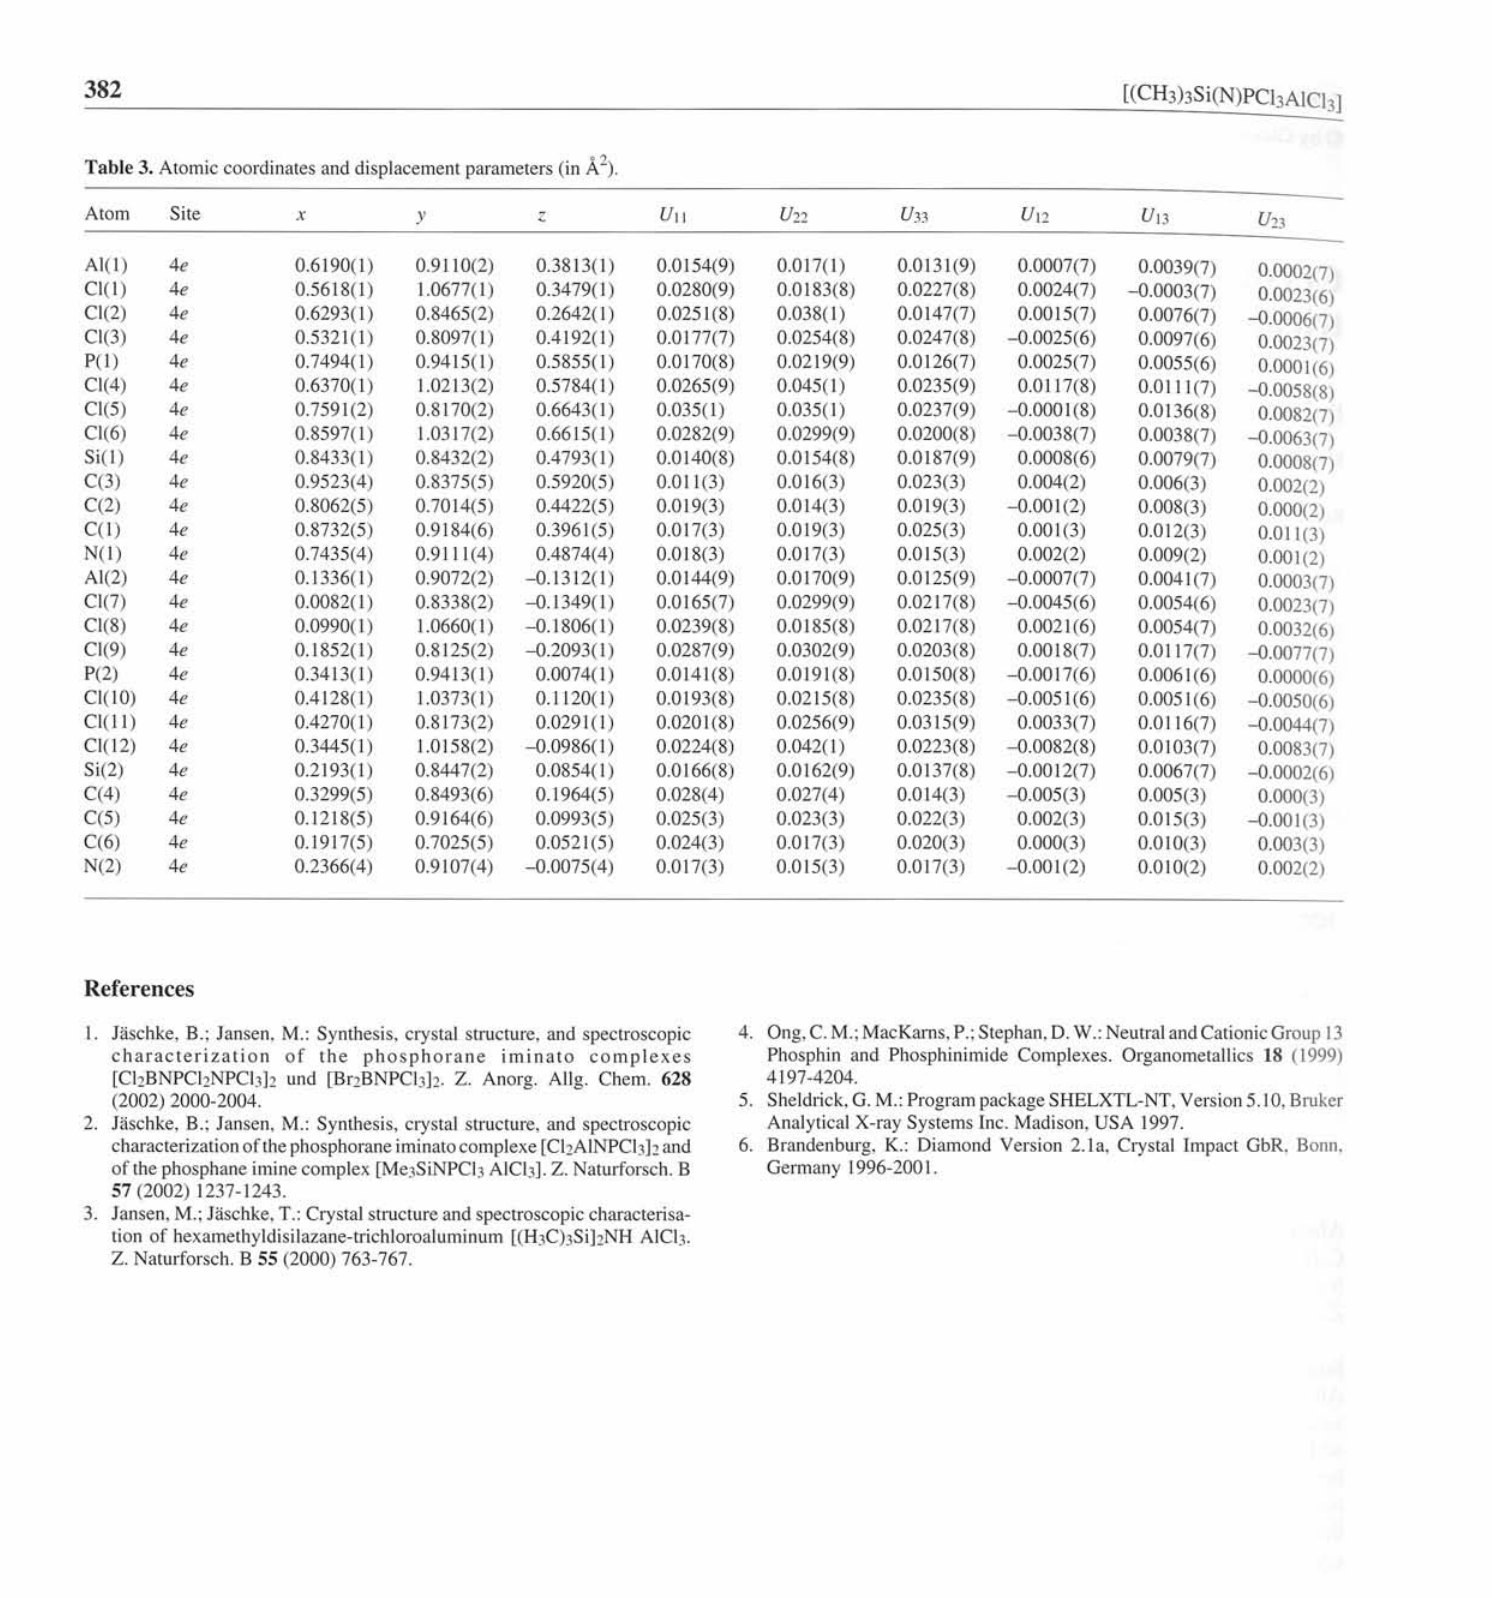
Table 3. Atomic coordinates and displacement parameters (in